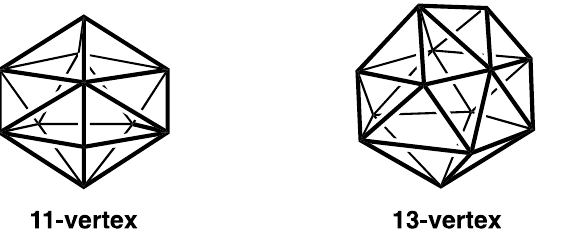
Figure 2. The four Frank ‐ Kasper deltahedra with the degree 6 vertices starred. (5) For the 11 ‐ and 13 ‐ vertex systems the closo deltahedra are less symmetrical and nec ‐ essarily contain vertices of three different degrees, namely 4, 5, and 6 (Figure 3).